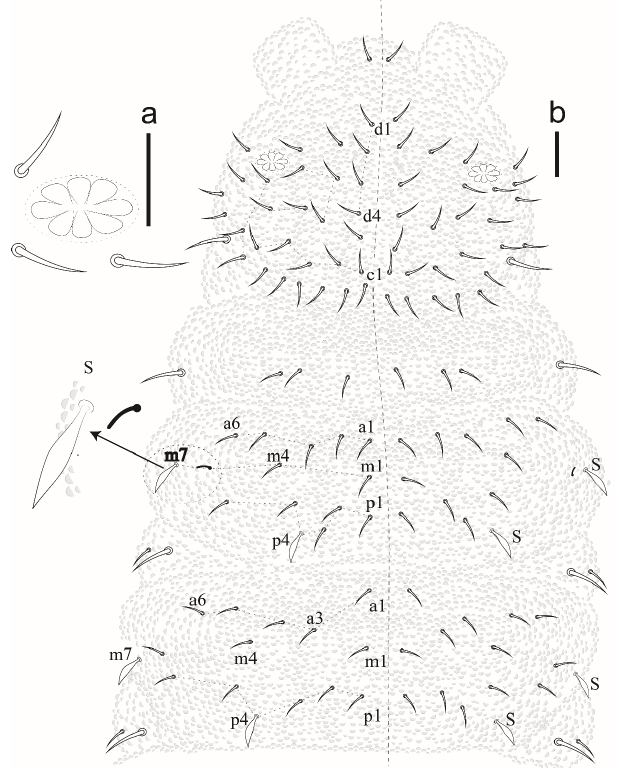
Figure 20. Willemia insularum sp. nov. ( a ) postantennal organ, scale bar: 20 µm. ( b ) dorsal view of head and thorax I–III. Scale bar: 10 µm.